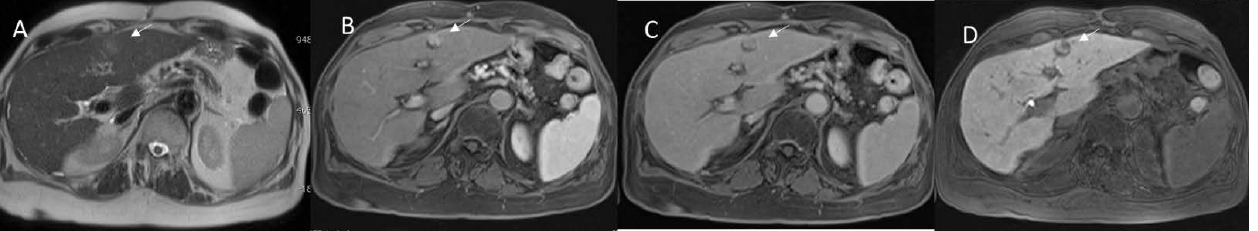
Figure 4. MRI assessment post n-CRT treatment: fibrotic response in T2-W axial (arrow) ( A ) and sagittal plane (arrow) ( B ). In the assessment of pancreatic cancer [75], the multidisciplinary team should make the choice concerning the lesion resectability following the acquisition of a complete stag- ing [76,77], based on CT and MRI studies [75,76]. The lesion resectability is related to the following three different features: anatomical (A), biological (B), and conditional (C). An- atomic features include tumor contact with the superior mesenteric artery and/or celiac artery of less than 180°, without showing stenosis or deformity; tumor contact with the common hepatic artery, without showing tumor contact with the proper hepatic artery and/or celiac artery; and tumor contact with the superior mesenteric vein and/or portal, without extending beyond the inferior border of the duodenum. Biological factors include potentially resectable diseases, based on anatomic criteria but with clinical findings sus-